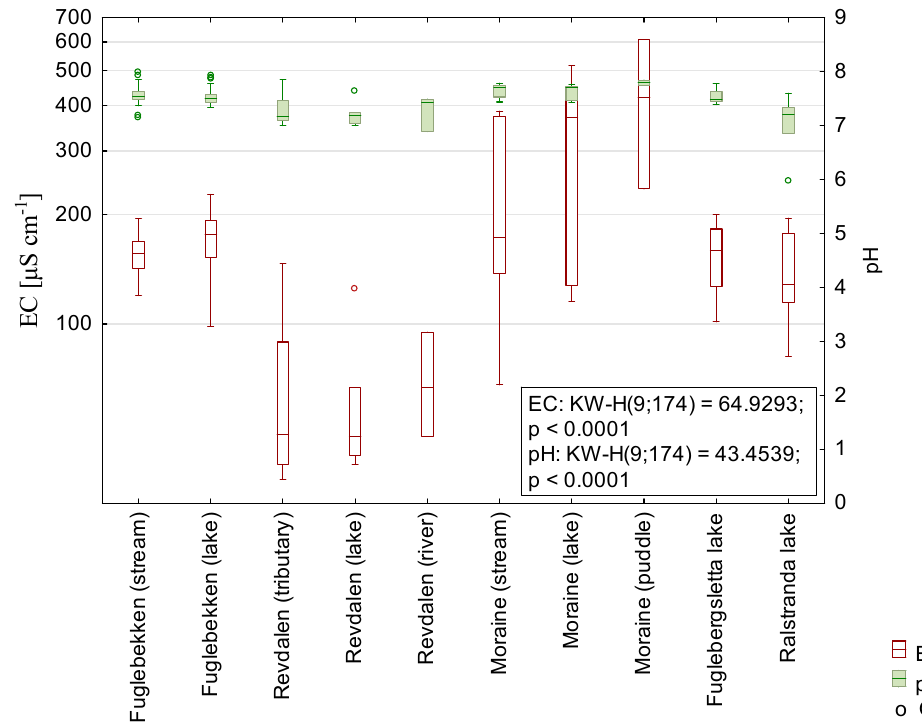
Figure 2. A box-and-whisker plot of the basic physicochemical parameters of the surface water samples collected in the Hornsund area: electrical conductivity (EC, in logarithmic scale) and reaction (pH). The box spans from first (Q 1 ) to the third quartile (Q 3 ), with median (Q 2 ) as a line inside. The whiskers show the range of results except outliers, which are defined as values further than 1.5 box span (Q 3 − Q 1 ) above Q 3 or below Q 1